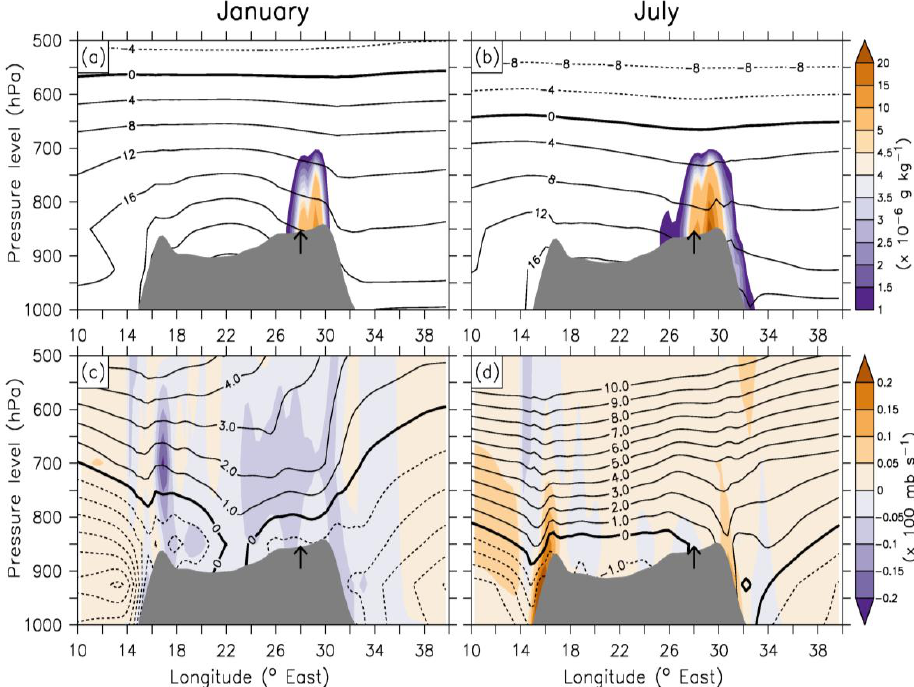
Fig. 10. Vertical cross section of HNO 3 concentration ( × 10 − 6 gkg − 1 ; shaded in upper panels) and temperature ( ◦ C; contours in upper panels), vertical wind component ( × 100mbs − 1 ; shaded in lower panels), and zonal wind component (ms − 1 ; contours in lower panels) at latitude 26 ◦ S in January and July. Topography is shown in grey colour and the location of the Highveld indicated with arrow ( ↑ ).